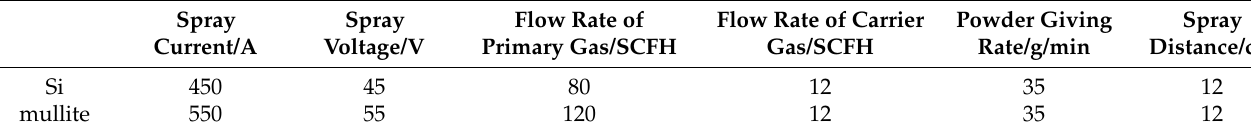
Table 2. Parameters of APS mullite/Si